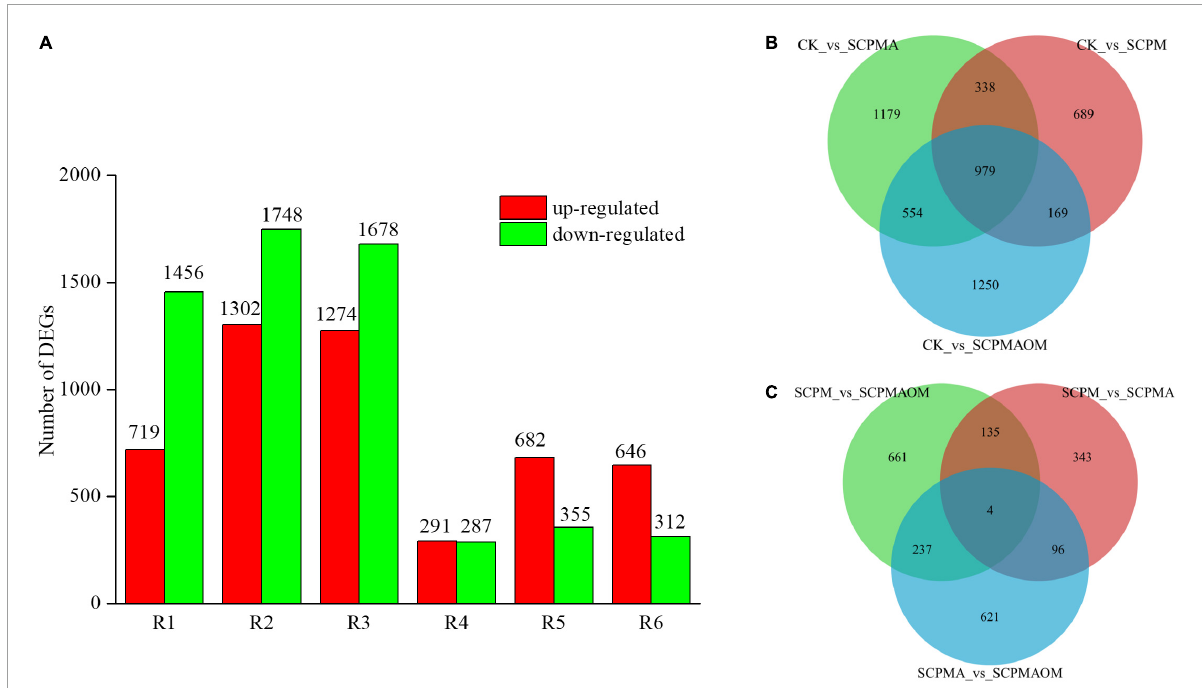
FIGURE1 Statistical analysis of the DEGs in different comparisons. (A) The number of up/down-regulated genes in different treatments. (B) Venn diagram of the DEGs from R1, R2, and R3. (C) Venn diagram of the DEGs from R4, R5, and R6. R1, CK vs. SCPM; R2, CK vs. SCPMA; R3, CK vs. SCPMAOM; R4, SCPM vs. SCPMA; R5, SCPM vs. SCPMAOM; R6, SCPMA vs.